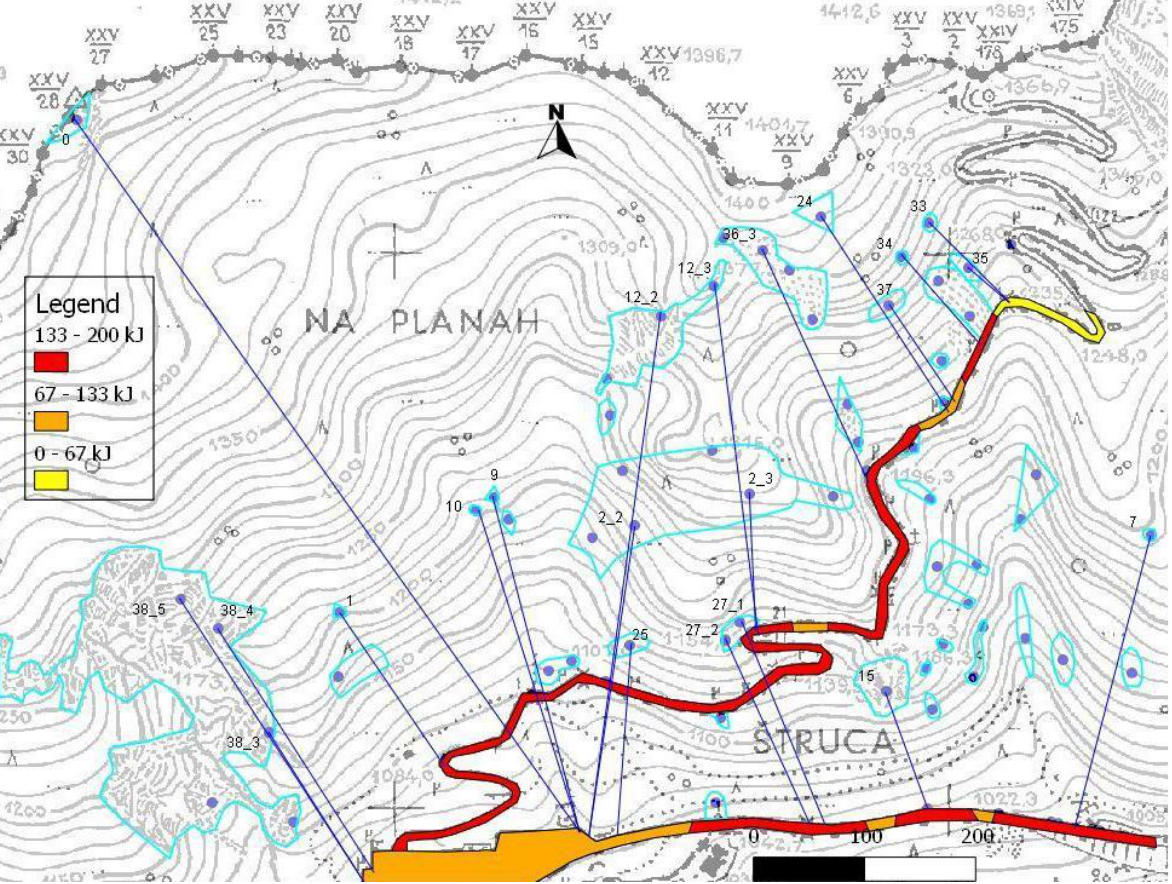
Figure 2. Rockfall susceptibility map based on the results of the Rockfor.NET model. Rock sources are outlined with light blue colour and with dark blue initial points of rockfall trajectories. Dark blue lines represent Rockfor.NET trajectories. Sections of the road are coloured according to the three susceptibility classes based on maximum kinetic energy of rocks in kilojoule (kJ). The deviation in both directions from the straight trajectory lines was